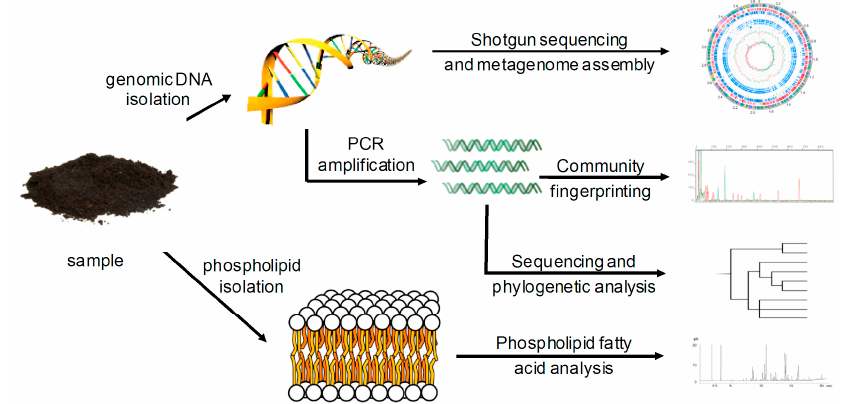
Figure 1. Microbial ecology approaches used to examine both cultivatable and uncultivatable fraction of the microbial community structure. This includes molecular methods like shotgun metagenome sequencing, community fingerprinting of polymerase chain reaction (PCR) products, sequencing of PCR products, and phospholipid fatty acid analysis.